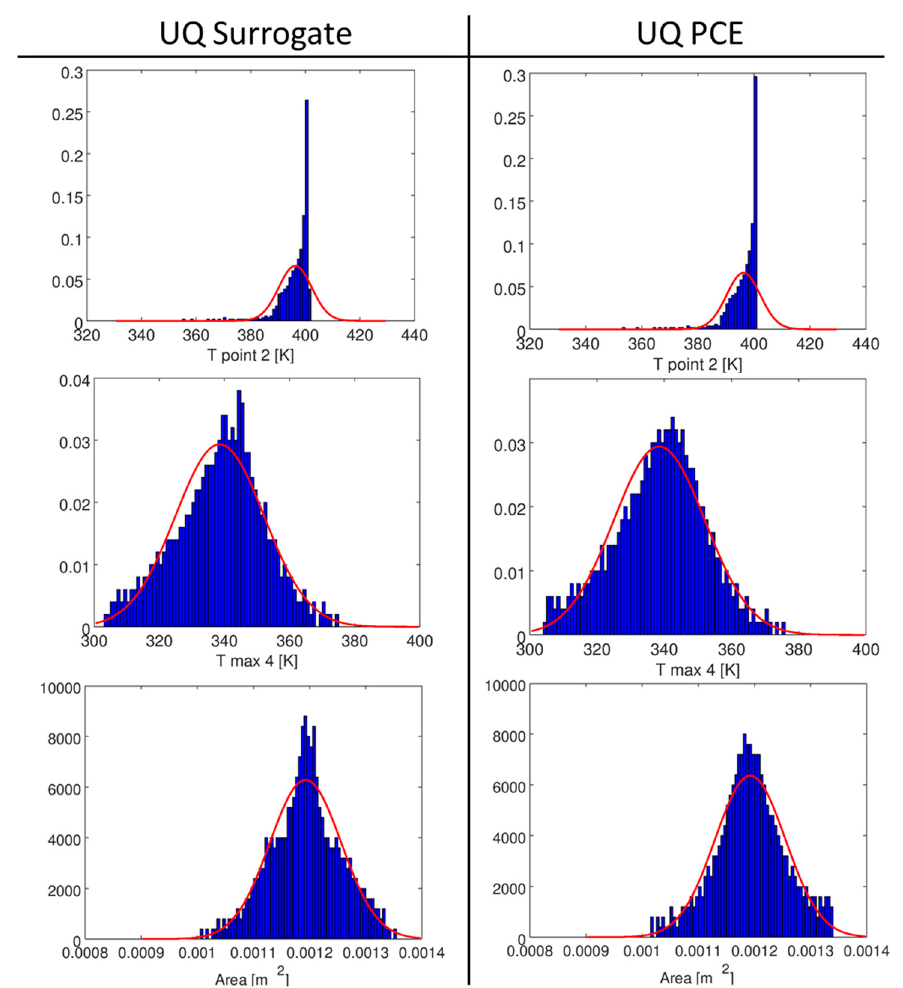
Figure 20. Comparison between surrogate-based and PCE results for certain QoI - exhaust gas outlet velocity.